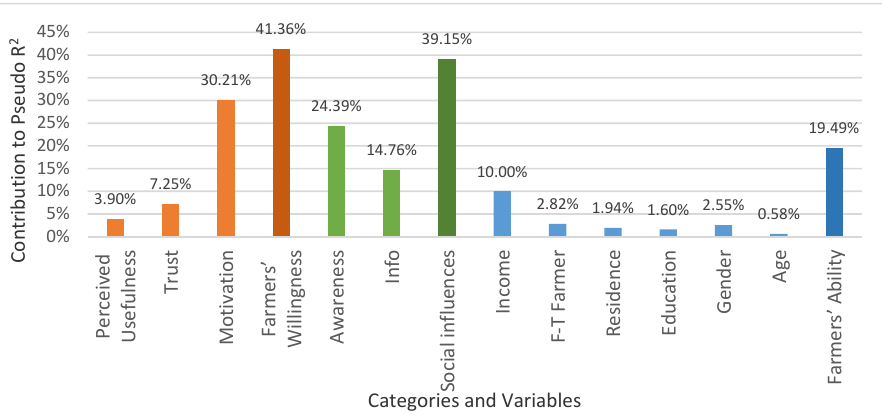
Figure 1. The contribution of the variables and factors’ categories on the Pseudo-R 2 coefficient.